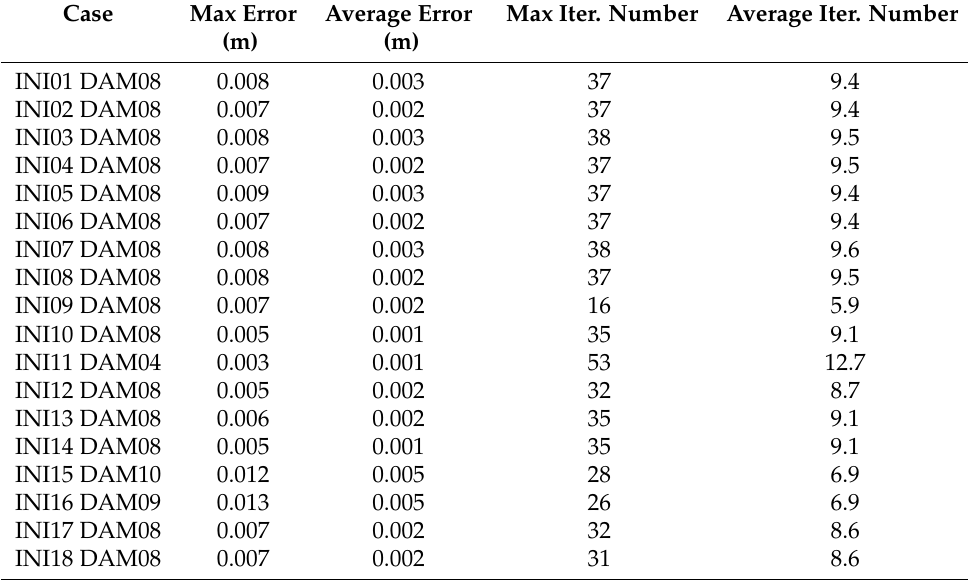
Table 14. GZ calculation results of 18 loading